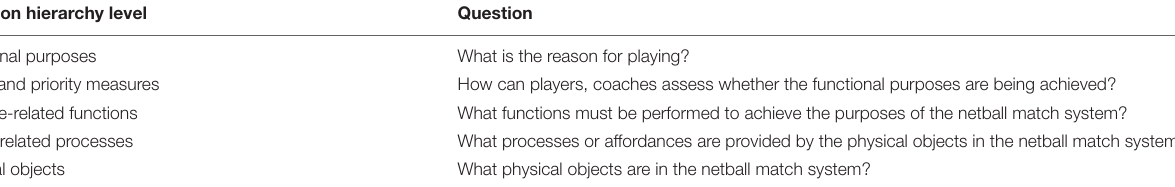
TABLE 2 | Abstraction hierarchy descriptions.